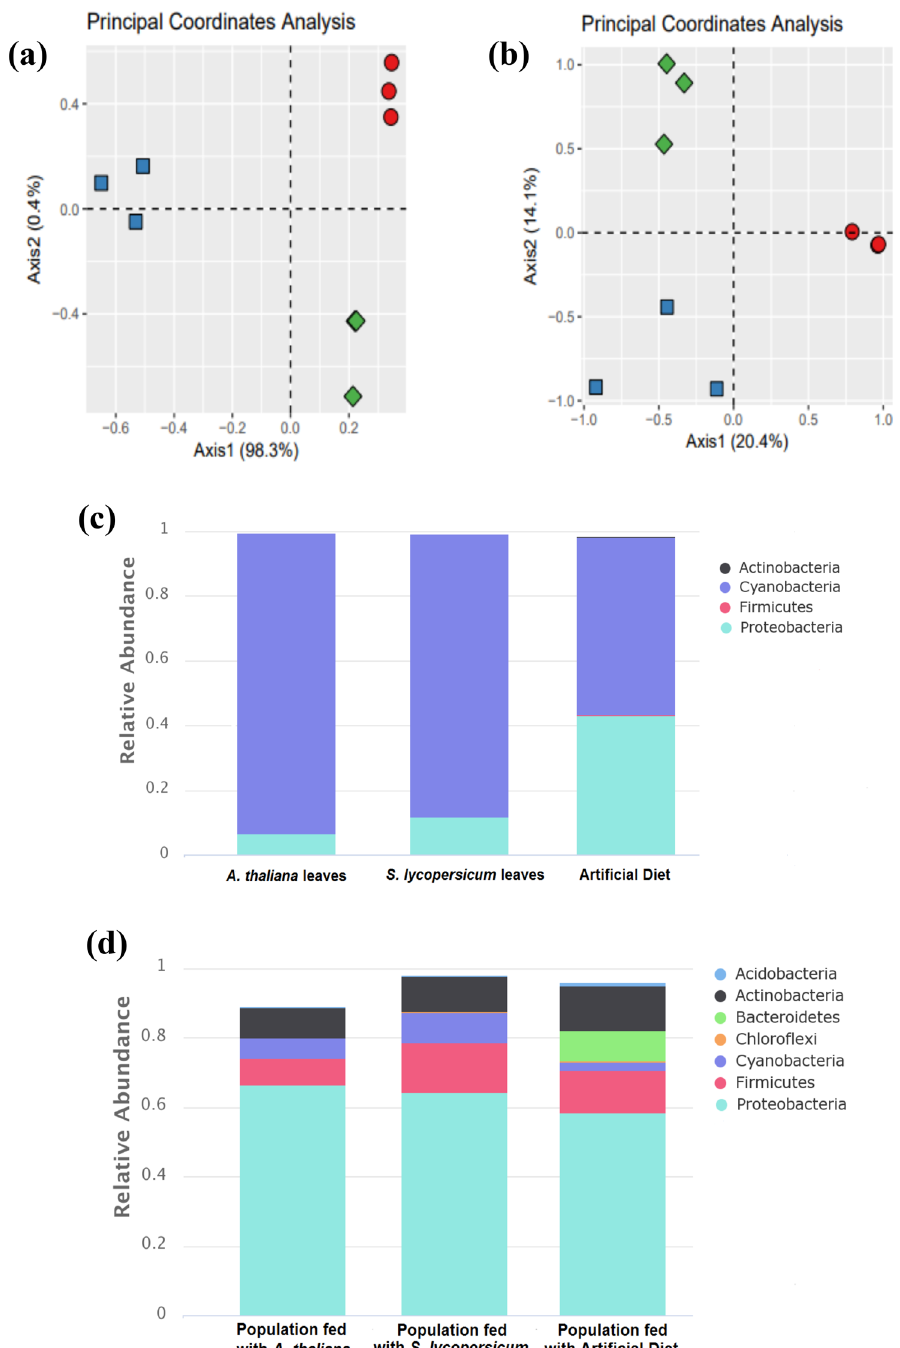
Figure 3. ( a ) Principal coordinate analysis (PCoA) of pairwise dissimilarities (Bray–Curtis index) for bacterial communities in A. thaliana leaves (red circles), S. lycopersicum leaves (green rhombi) and in the artificial diet (blue squares). ( b ). Principal coordinate analysis (PCoA) of pairwise dissimilarities (Bray–Curtis index) for bacterial communities in guts of Trichoplusia ni derived from populations fed with each different diet. ( c ). Bacterial relative abundance measures from ASVs classified at the phyla level present in each diet ( A. thaliana leaves , S. lycopersicum leaves or artificial diet ) . ANCOVA (p < 0.05). ( d ). Bacterial relative abundances of ASVs classified at the phyla level in Trichoplusia ni guts samples from populations of Trichoplusia ni fed with specific diets. The size of each segment in the ( c ) and the ( d ) chart is proportional to the relative abundance of the ASVs assigned to each